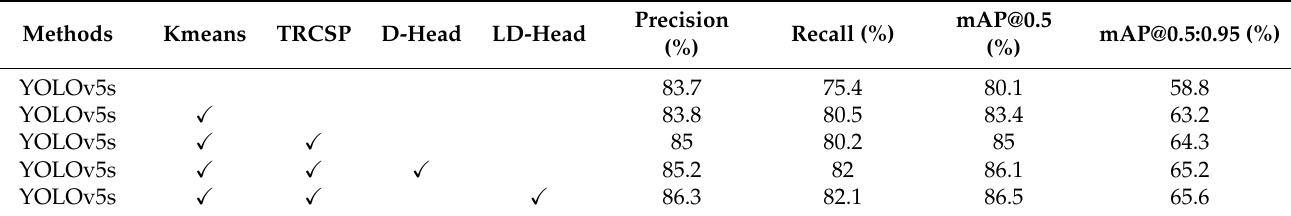
Table 4. Ablation experiment based on